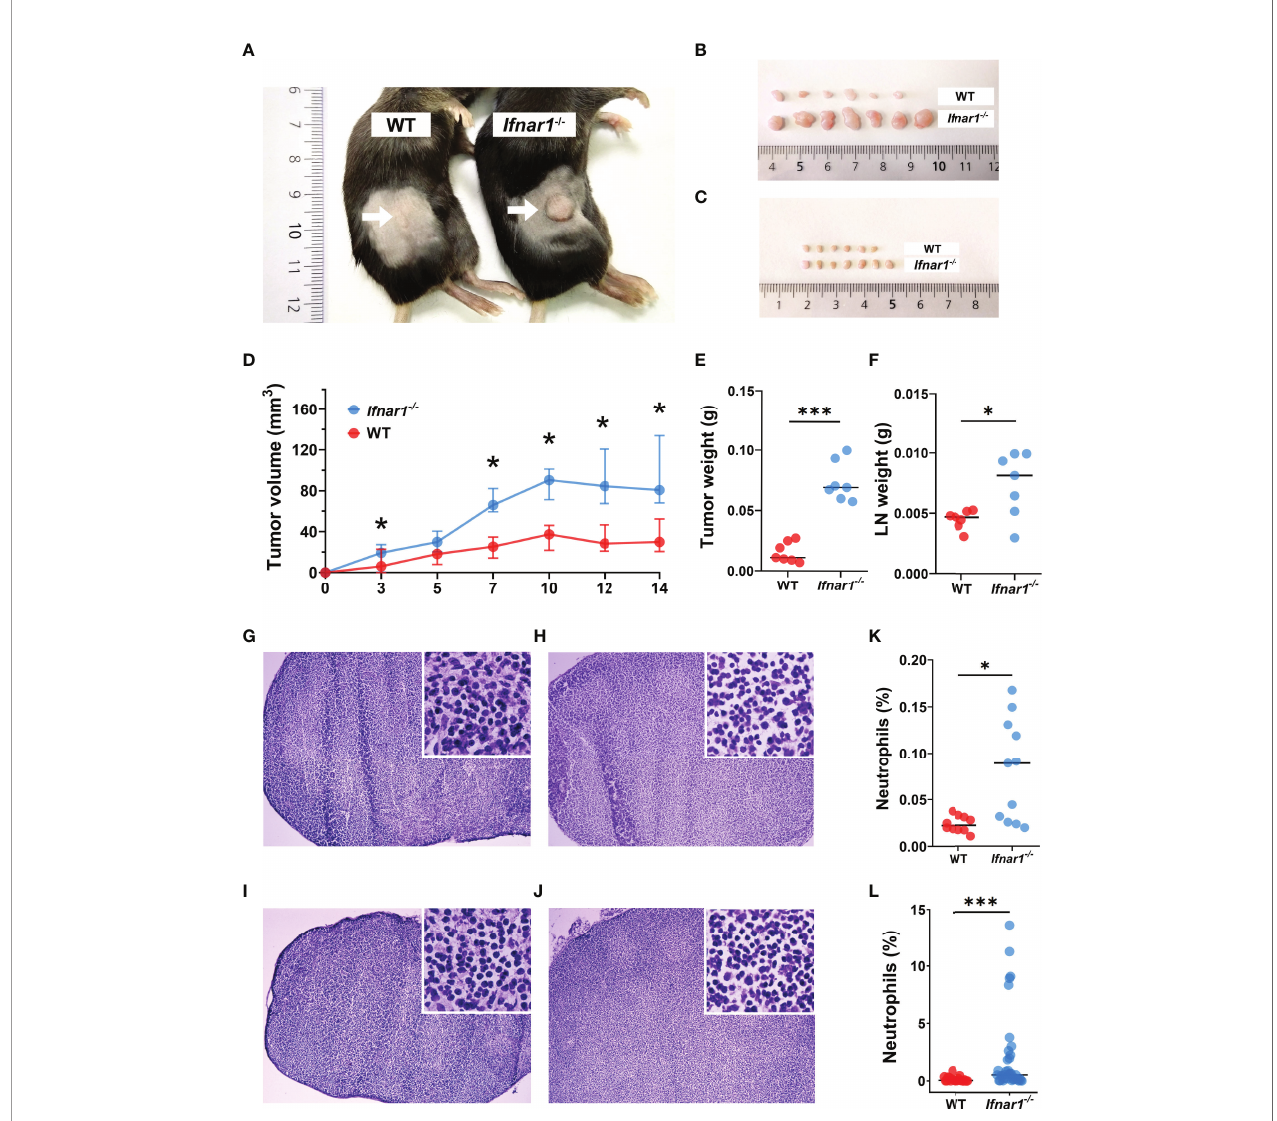
FIGURE 1 | Type I IFN de fi ciency in mice results in accelerated tumor growth and enhanced TDLN in fi ltration by neutrophils. (A, B) Increased tumor size in Ifnar1 -/- mice. Tumor cells were injected s.c. into the right fl ank of mice. Tumor volume was measured during tumor development. Mice were sacri fi ced on day 14 post tumor induction; tumors were isolated and analyzed. Exempli fi ed picture of the fl ank tumor in mice (A) , comparison of tumor size between mice from one exempli fi ed experiment are shown (B) . (C) Increased TDLNs size in Ifnar1 -/- mice. Mice were sacri fi ced on day 14 post tumor induction; LNs were isolated and analyzed. Comparison of LN size between mice from one exempli fi ed experiment are shown. (D) Accelerated tumor growth in Ifnar1 -/- mice. Tumor growth was monitored 14 days. (E) Elevated weight of tumors in Ifnar1 -/- mice. Tumors were set and monitored as described above, at day 14 tumors were removed and their weight assessed. (F) Higher LNs weight in Ifnar1 -/- mice. (G – J) No metastases in TDLNs after 14 d post tumor cell injection. Hematoxylin and eosin (H&E) staining was performed on all explanted lymph nodes of tumor-bearing and tumor-free mice to con fi rm metastasis-free status of tumor-draining lymph nodes (TDLNs). WT tumor-free (G) , WT tumor-bearing (H), Ifnar1 -/- tumor-free (I) and Ifnar1 -/- tumor-bearing (J) mice. (K, L) The increased numbers of neutrophils in TDLNs of Ifnar1 -/- tumor-bearing mice were quanti fi ed by fl ow cytometry (K) and immuno fl uorescent histological staining (L). The percentage of Ly6G + CD11b + neutrophils from single alive cells in TDLN (presented in panel K) (gating strategy is presented in Figure S4 ). In panel (L) the percentage of Ly6G + neutrophils was calculated from DAPI + nucleated cells. Representative results are shown for (A-L). For all experiments at least three independent experiments were performed, with at least fi ve mice per group, n=5. For comparison of two independent groups, Mann-Whitney U test was used. Data are shown as median with interquartile range (D) and individual values with median (E, F, K, L). *p < 0.05, 0.01, ***p <